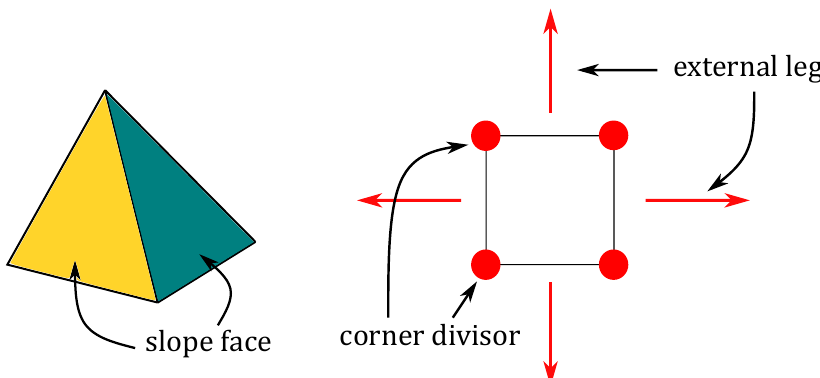
Figure 1. Three-dimensional crystal (pyramid partition) and toric diagram of the conifold geometry. Each of the slope face corresponds to the corner divisor of the toric diagram. External legs of the toric diagram are lines dual to the edges of the toric